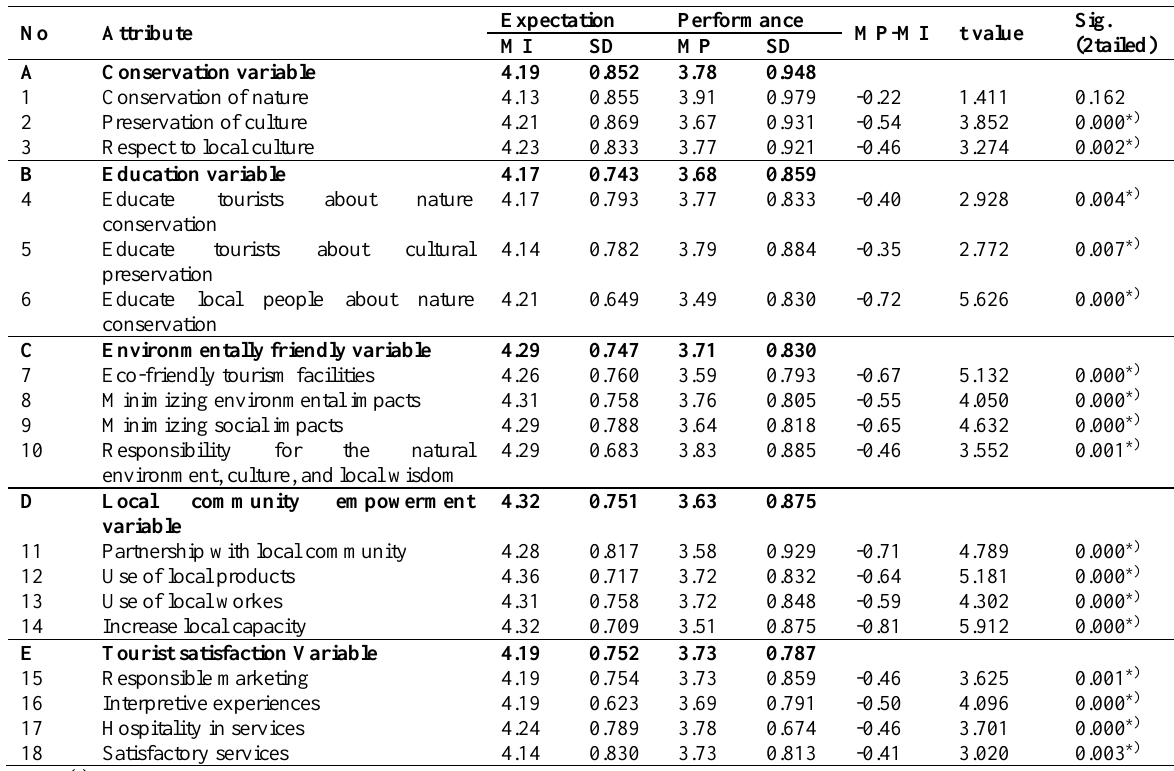
Table 2: The mean score of expectation and performance of the attributes of ecotourism principles on the diving tourism practices in